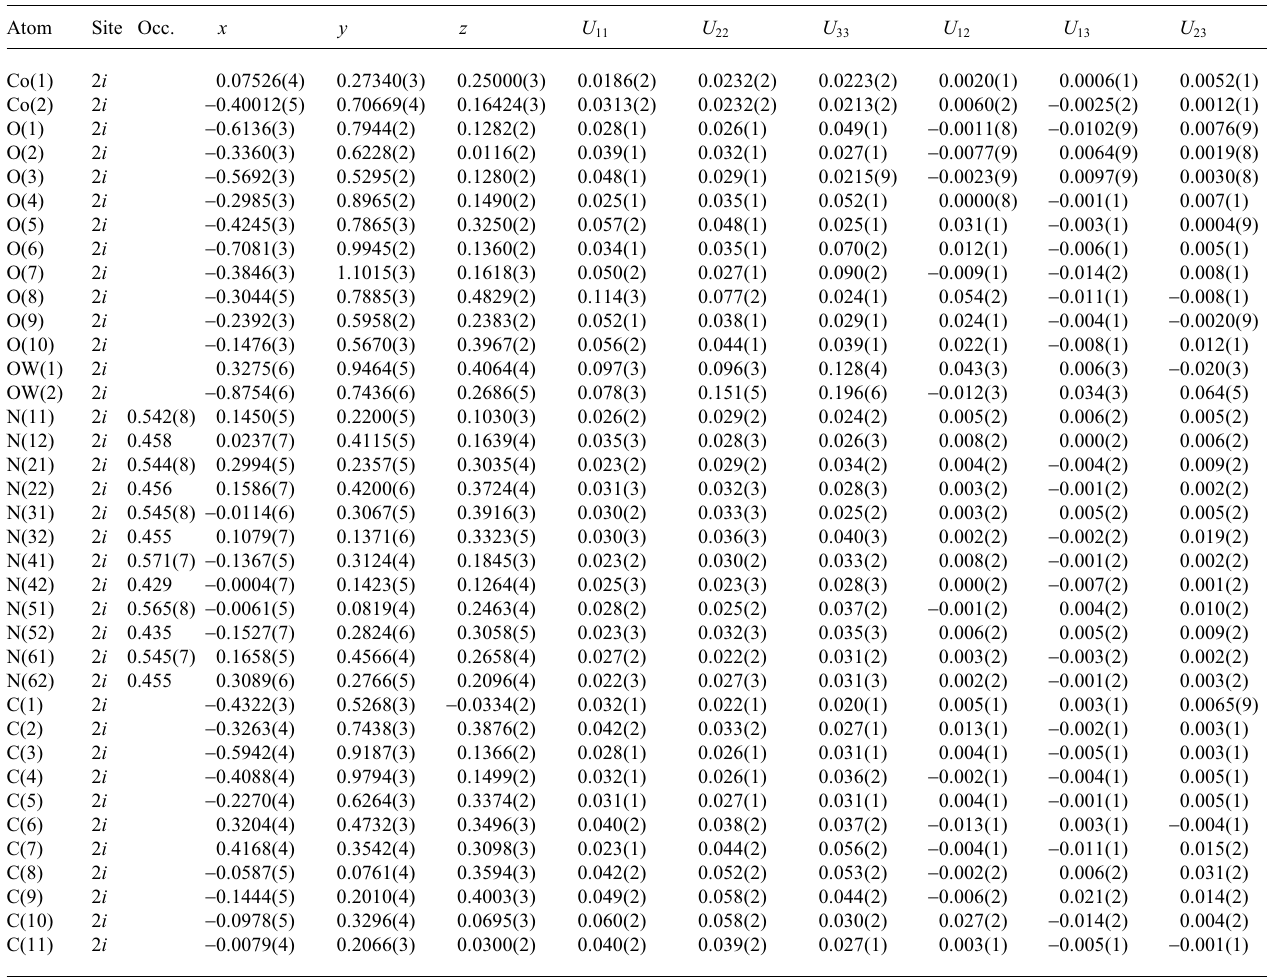
Table 2. Atomic coordinates and displacement parameters (in Å 2